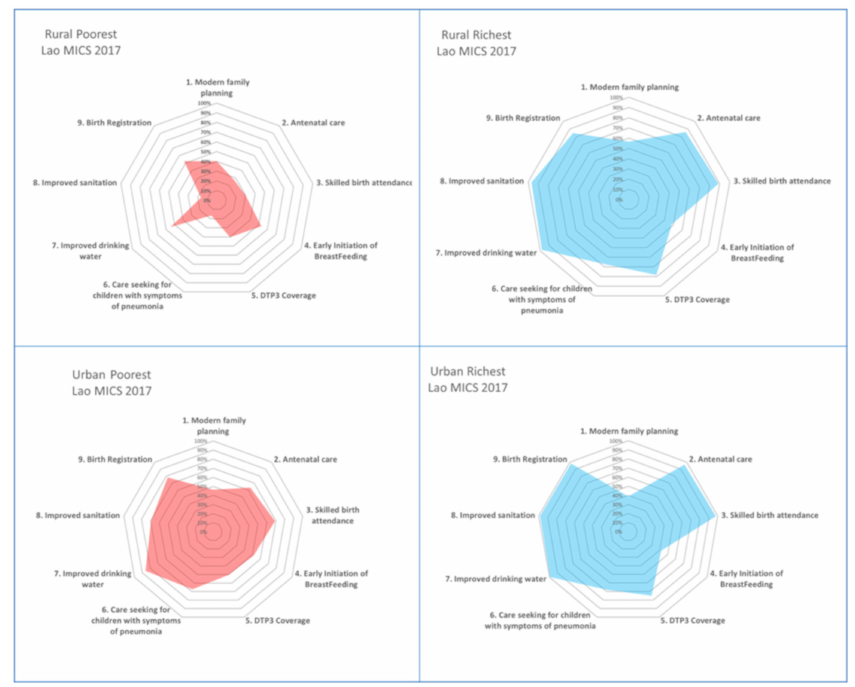
Figure 4. Synergies of vulnerability: urban / rural and rich-poor quintiles, Lao PDR. Data source: Lao PDR MICS 2017